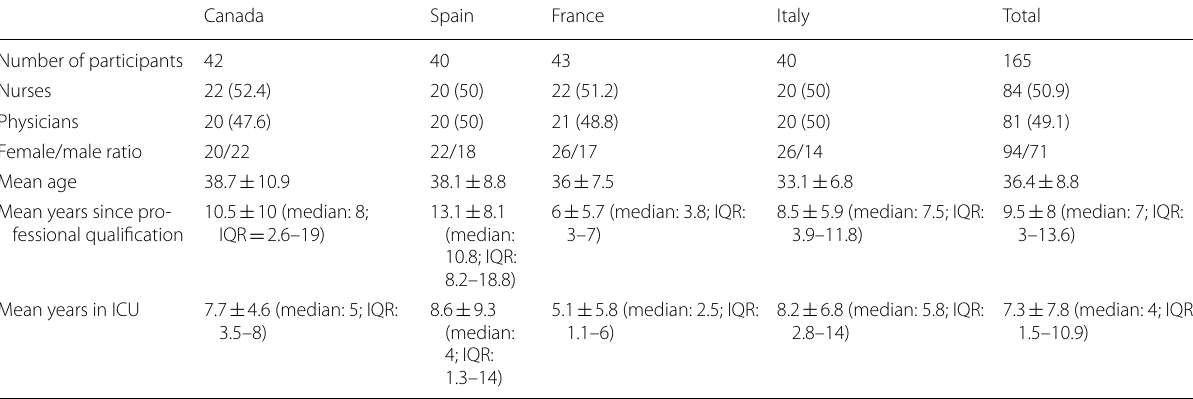
Data represents n (%) or means